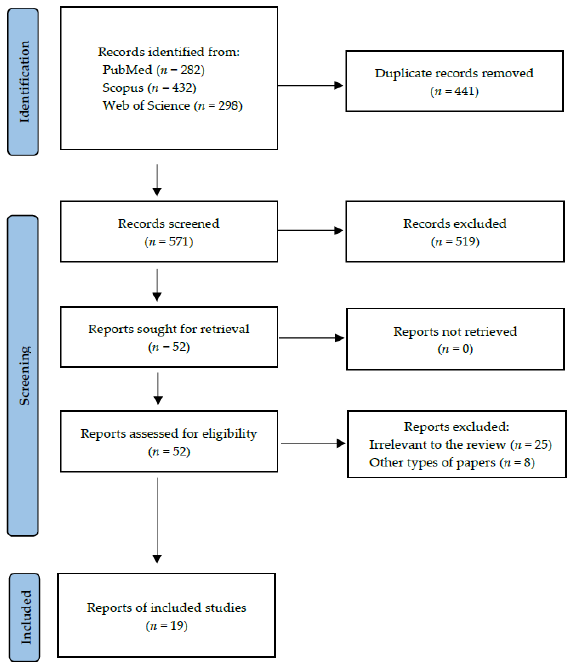
Figure 2. PRISMA flow diagram presenting search strategy.